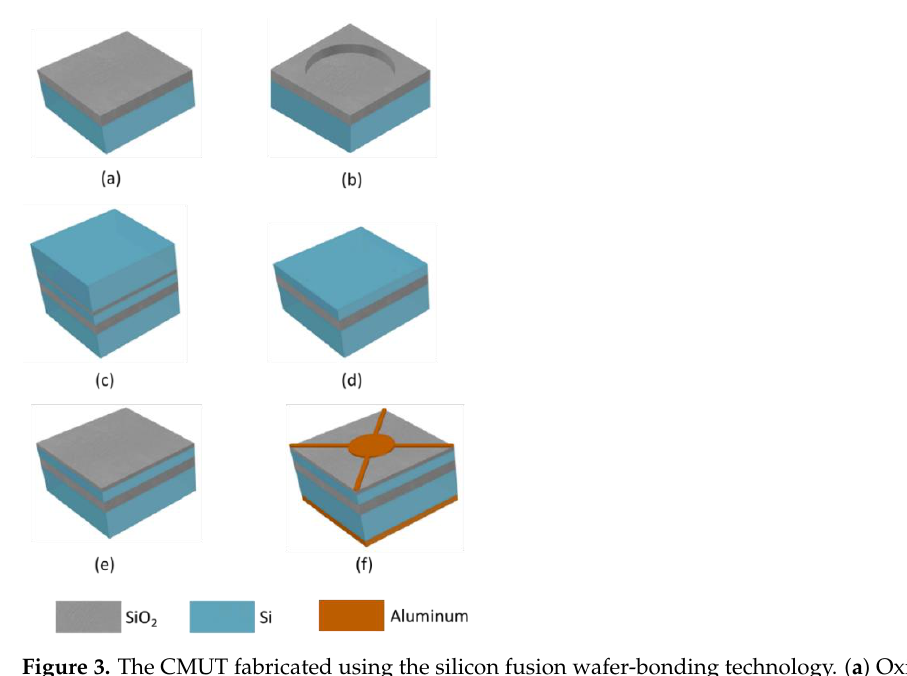
Figure 3. The CMUT fabricated using the silicon fusion wafer-bonding technology. ( a ) Oxide mono-crystalline silicon wafer; ( b ) cavity definition; ( c ) wafer-bonding of the oxide mono-crystalline silicon wafer and SOI wafer; ( d ) removal of the handle and the BOX layer of the SOI wafer to release the membranes; ( e ) depositing a 100-nm thick oxide silicon layer as an insulator dielectric; ( f ) fabrication of the top and bottom electrodes.